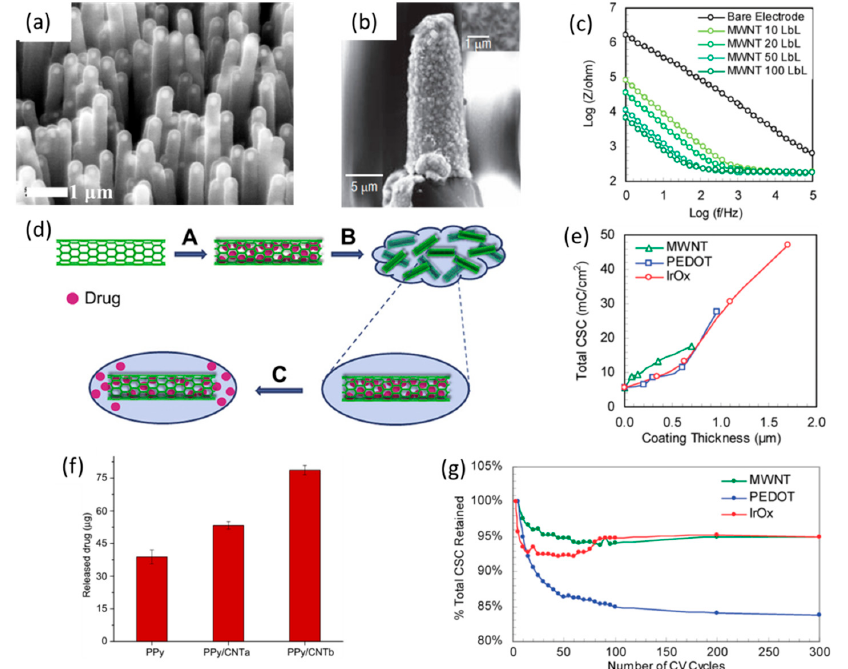
Figure 4. SEM images of ( a ) an as-grown carbon nanofiber array and ( b ) CNT coating by covalent attachment. ( a ) is reproduced with permission from [135], Copyright 2006, Wiley Online Library. ( b ) is reproduced with permission from [119], Copyright 2008, nature.com. ( c ) EIS of CNT coatings with different thicknesses. ( d ) Schematic of the drug loading and release process of CNT nano-reservoirs. ( e ) The total CSC of CNTs, PEDOT and IrO x coatings. ( f ) Dex released from different PPy films under electric stimulation for 20 h. The electric stimulation applied was a 50% duty cycle of square wave, 2 V for 5 s followed by 0 V for 5 s. The data are shown ± the standard deviation ( n = 3 for each case). ( g ) The total charge storage capacities (CSC) of the CNTS, PEDOT and IrO x coated electrodes were recorded while being subjected to 300 cyclic voltammetry scanning cycles. ( c , e , g ) are reproduced with permission from [117], Copyright 2009, ACS. ( d , f ) are reproduced with permission from [145], Copyright 2011, Elsevier.